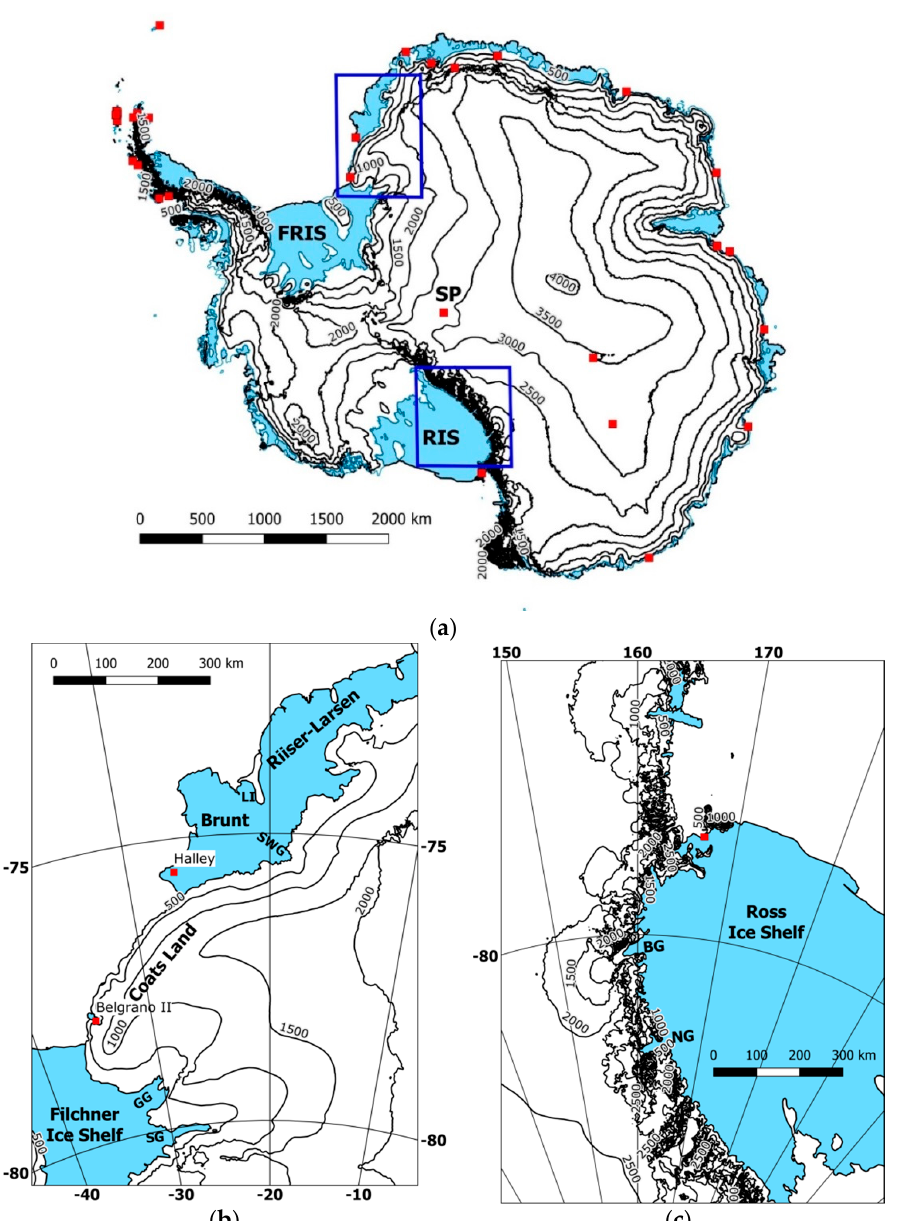
Figure 1. ( a ) Map of the Antarctic with topography (isolines). Permanent research stations are marked by red squares. Ice shelf areas are light blue (FRIS = Filchner-Ronne Ice Shelf, RIS = Ross Ice Shelf). The blue rectangles mark the focus areas of this study. Data source: RAMP2 ([9]). Part ( b ): As ( a ), but for the study area in the eastern Weddell Sea with SWG = Stancomb-Wills Glacier, LI = Lyddan Island, GG = Goldsmith Glacier, SG = Slessor Glacier. Part ( c ): As ( a ), but for the study area of the Ross Ice Shelf with BG = Byrd Glacier, NG = Nimrod Glacier.